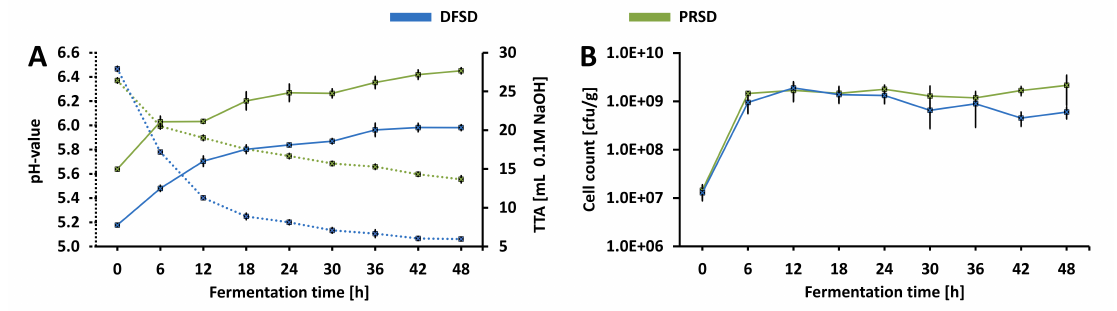
Figure 1. Acidification and microbial growth of Leuconostoc citreum TR116 in DFSD and PRSD during 48 h of fermentation: ( A ) Development of pH (represented by dotted lines) and total titratable acids (TTA) (represented by solid lines); ( B ) Determined cell